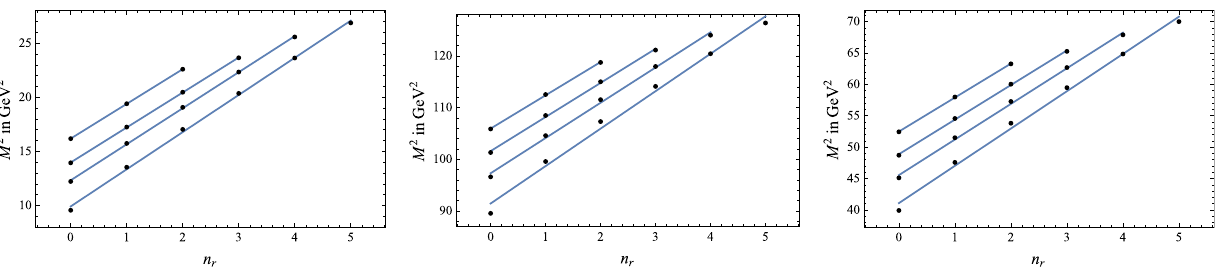
Fig. 2 Parent and daughter Regge trajectories ( J , M 2 ) for charmonia (left), bottomonia (middle) and B c (right) mesons with unnatural parity ( P = ( − 1 ) J + 1 )